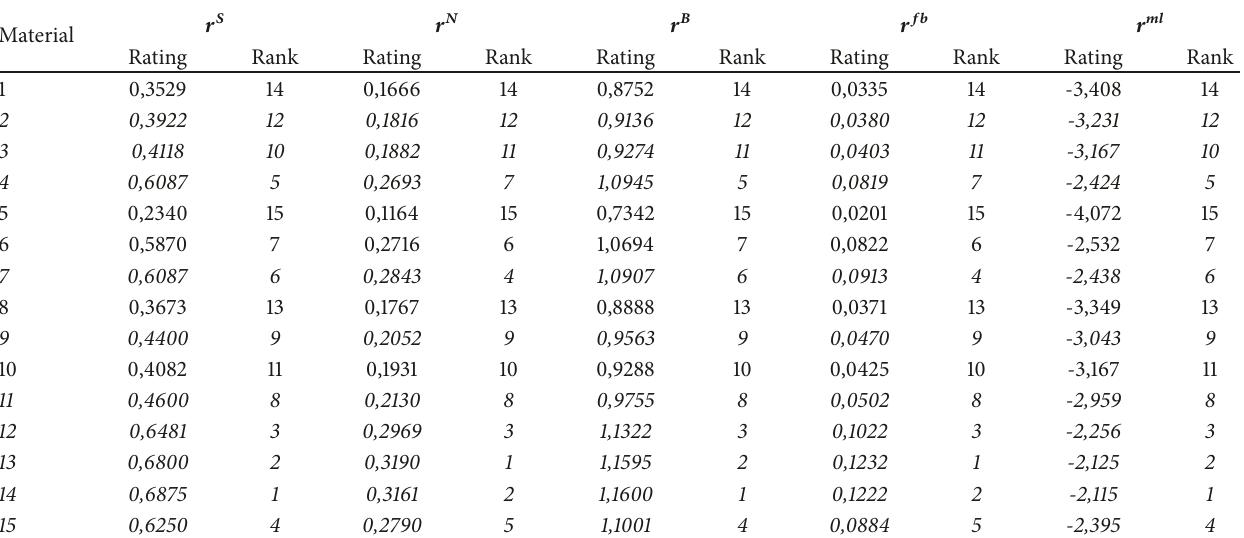
Table 1: Materials ranked by proposed